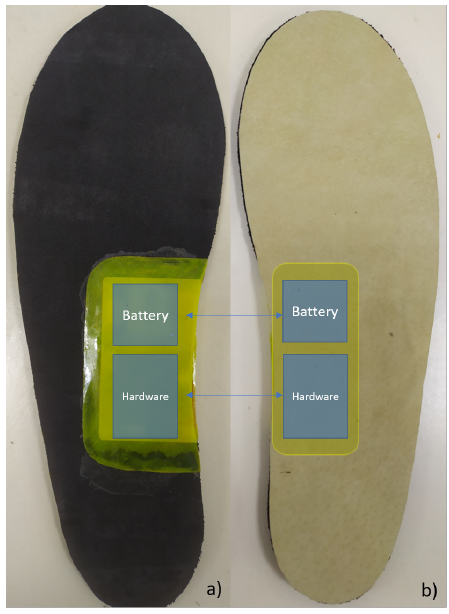
Figure 7. Final developed instrumented insole